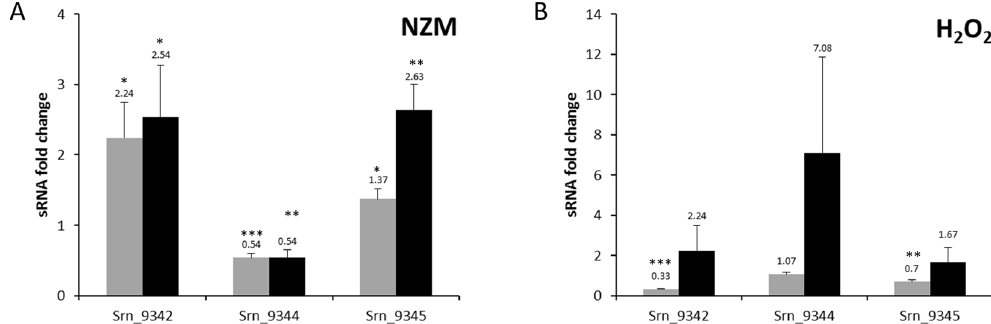
Figure 8. Differential expression of the srn_9342-9346 locus. sRNA expression levels ( A ) after nutrient starvation in NZM medium and ( B ) under oxidative stress (10 mM H 2 O 2 ). The fold changes were calculated after 30 minutes (grey bars) and 1 hour (black bars) of stress using the TSB condition as a control. HU (for NZM) or 5 S cDNA levels were used as internal controls. Data presented are the mean of three independent experiments, all performed in duplicate. A student t-test was performed to determine differences with unstressed condition ( * p < 0.05, ** p < 0.01, *** p <